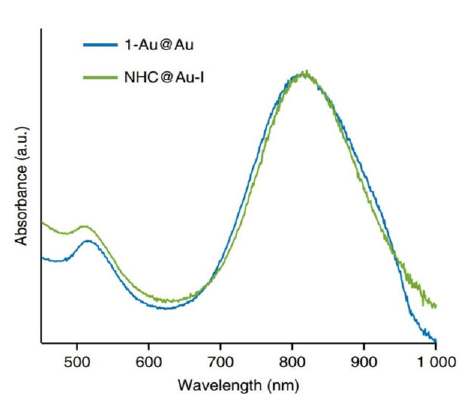
Figure 7. UV—vis spectra for 1-Au@Au andNHC@Au-i indicate that the size and shape of the nanorods are preserved when transforming 1-Au@Au to NHC@Au-i (i.e., adatom incorporation does not have a dramatic effect on nanorods optical properties) [44,45]. Reprinted with permission from ref. [44,45]. Copyright 2018 RSC